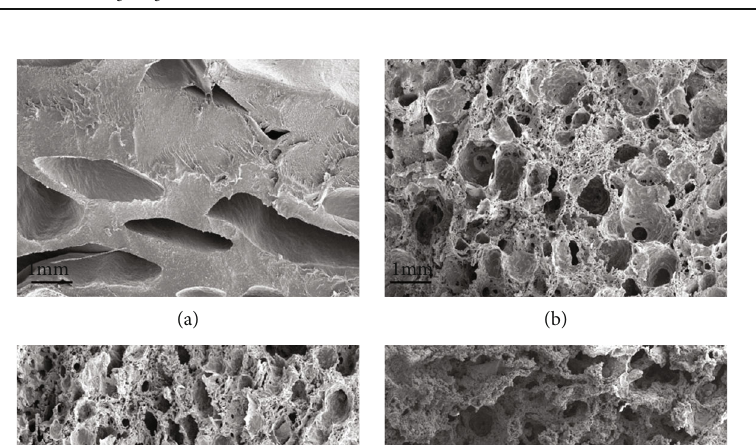
Figure 8: SEM images of the PVA composite aerogels: (a) PVA/H (d) PVA/15APP-CS/H